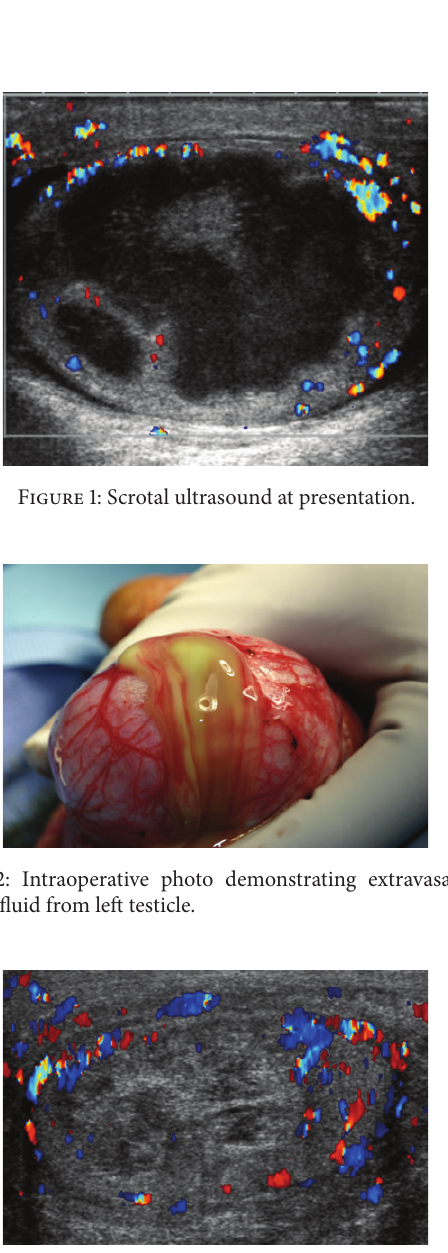
Figure 3: Postoperative scrotal